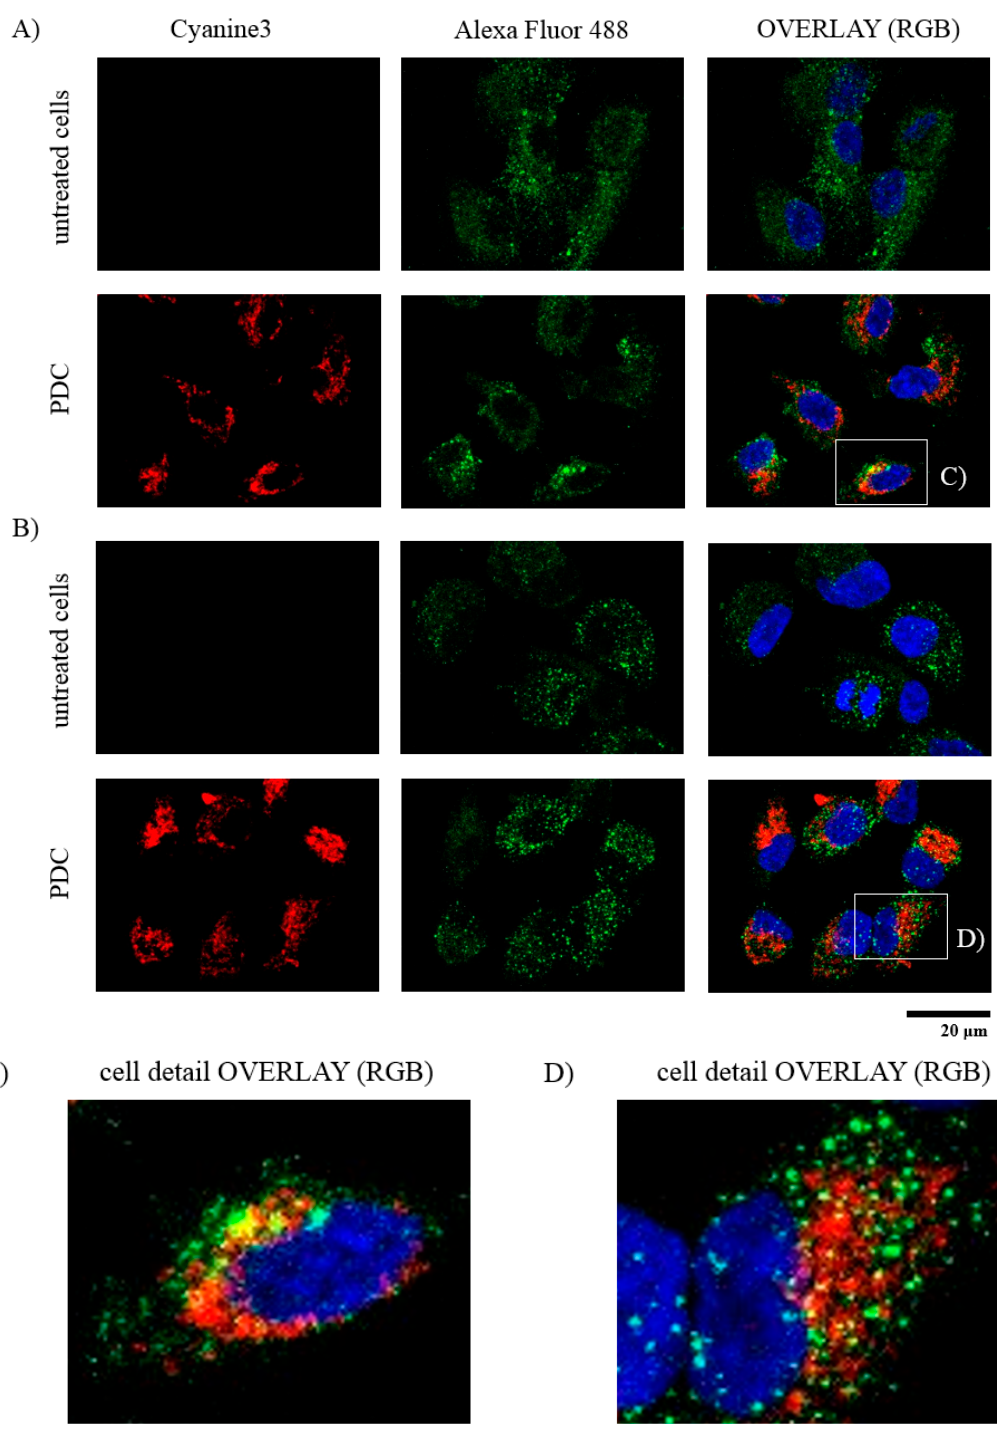
Figure 8. Confocal microscopic images of ARPE-19 cells incubated with 0.2 mg/mL of pullulan-dexamethasone-cyanine3 (PDC) nanoparticles in red. ( A ) Endosomes were stained in green with rabbit anti-EEA1 and Alexa Fluor 488 labeled goat anti-rabbit IgG H&L secondary antibody. ( B ) Lysosomes were stained in green with rat anti-mouse anti-LAMP1 and Alexa Fluor 488 labeled goat anti-rat IgG H&L secondary antibody. Nuclei were stained with DAPI in blue. RGB: overlay of red, green and blue channels for organelles/nanoparticles co-localization. ( C ) Magnification of the cell in the white square from ( A ) endosomes/nanoparticles from overlay (RGB). ( D ) Magnification of the cell in the white square from ( B ) lysosomes/na- noparticles from overlay (RGB). Bar size: 20 μ m. (Note: bright field; RG: overlay of red and green channels are in SI-8, Figure S8).